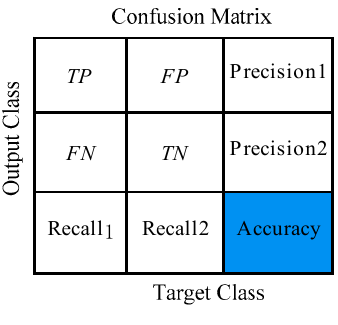
Figure 6. Confusion matrix.